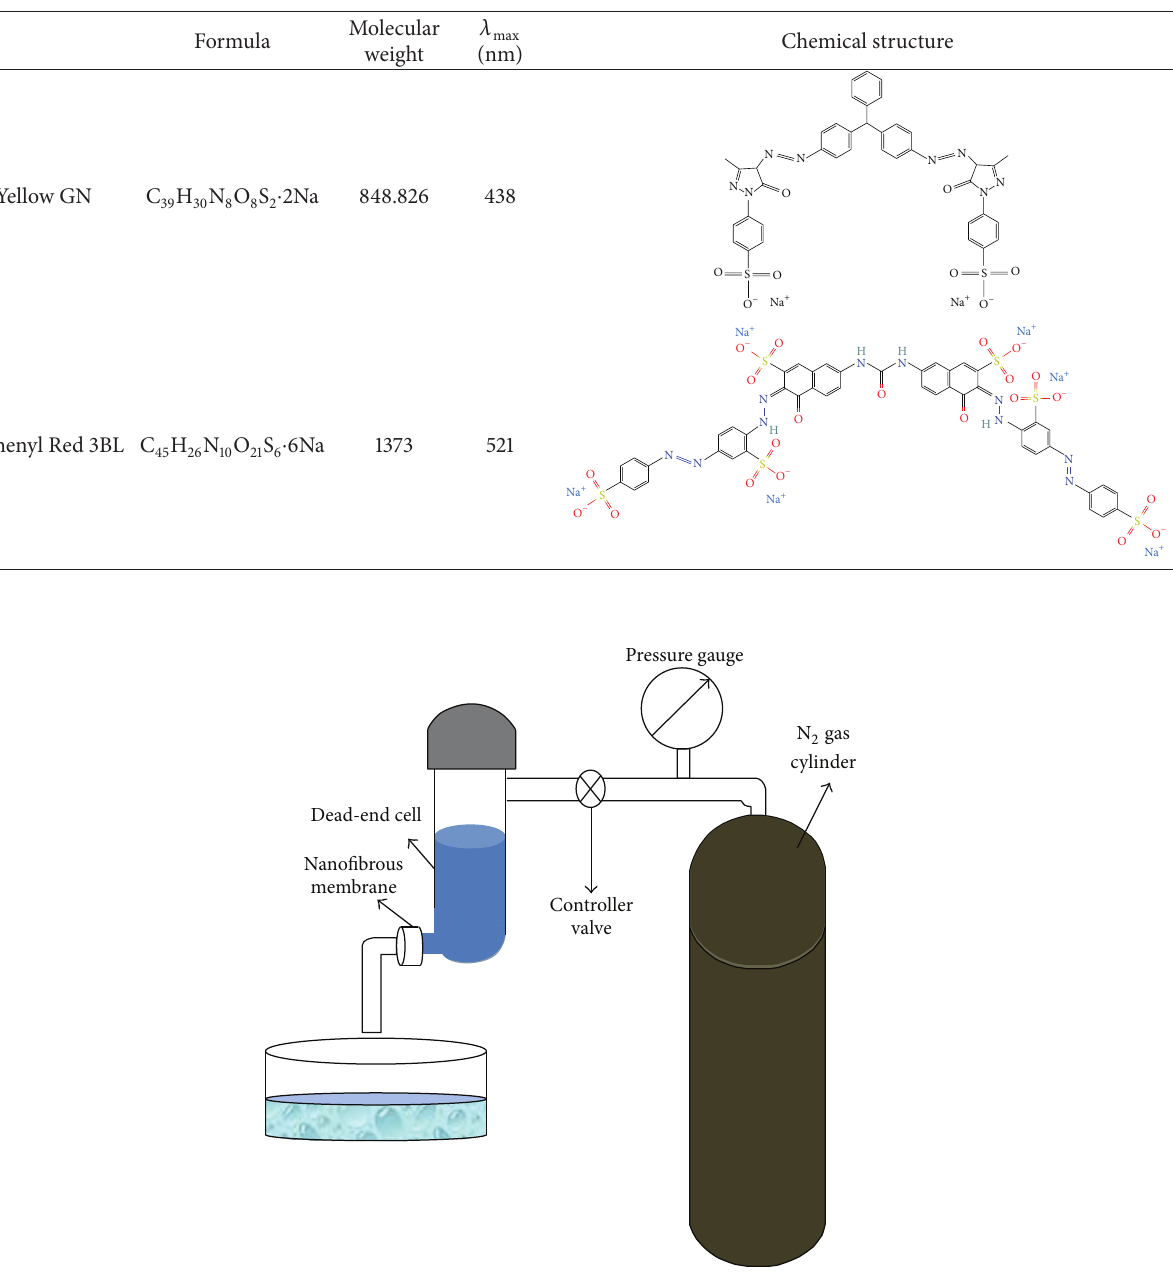
Figure 2: Schematic diagram of dead-end adsorption